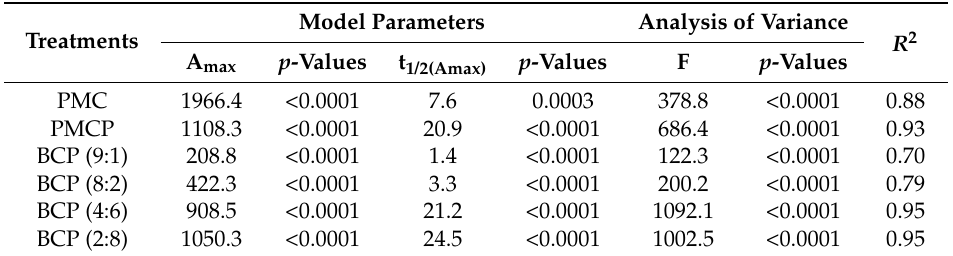
Table 3. Estimation model for accumulated PO 4 -P releasing amount from different types of biochar